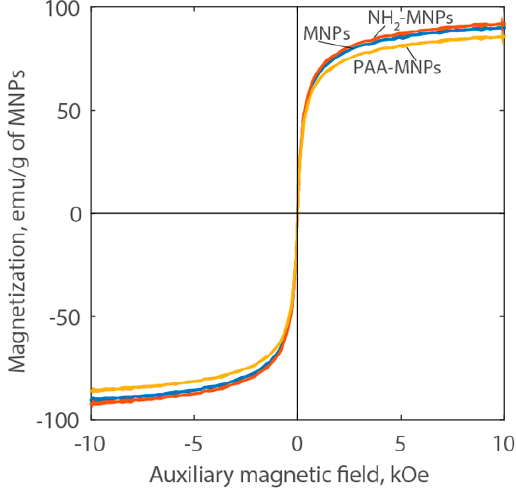
Figure 5. Langevin curves of MNPs, NH 2 -MNPs, and PAA-MNPs at room temperature.